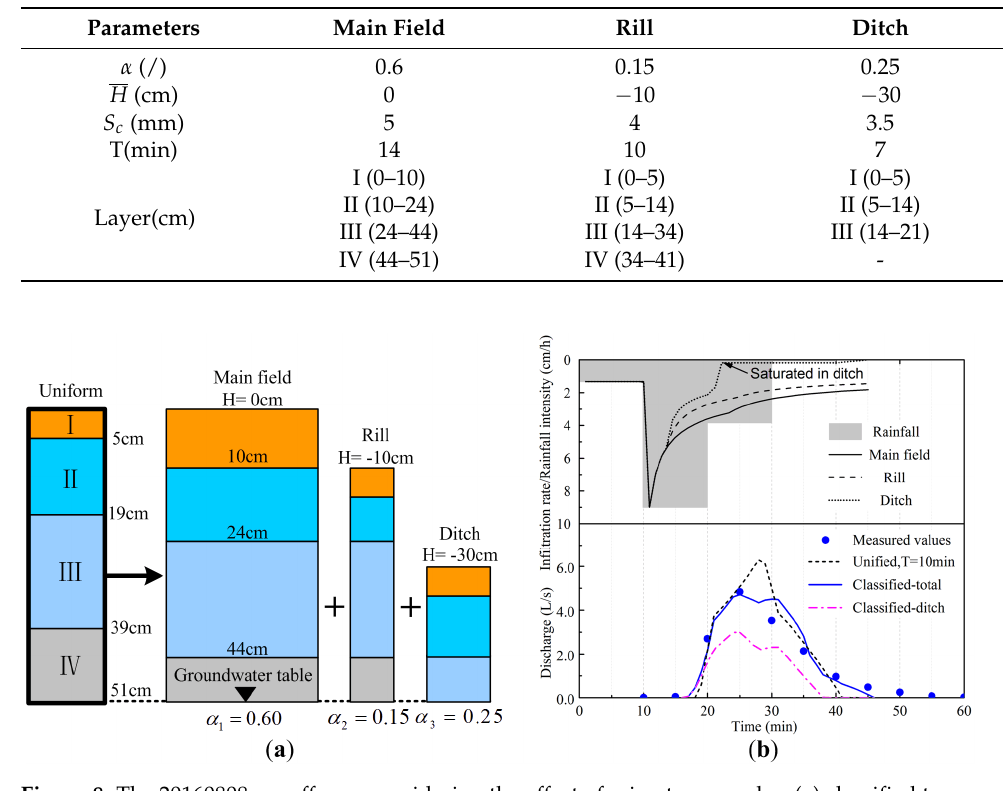
Table 4. Parameters of three kinds of topographic subunits in 20160808 runoff case.